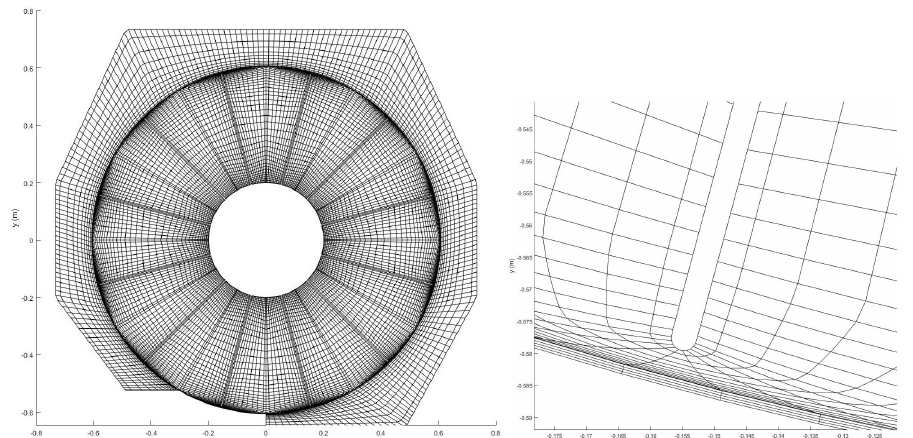
Figure 5. Part of the computational mesh around the